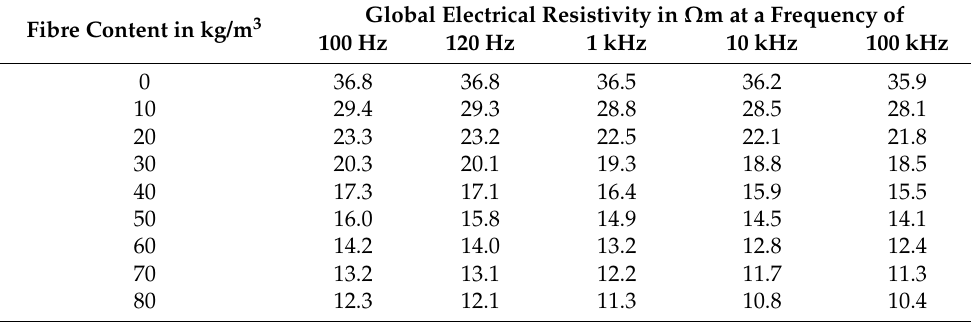
Table A34. Results of the resistivity measurements of the concrete mixture 52-65-270-00.